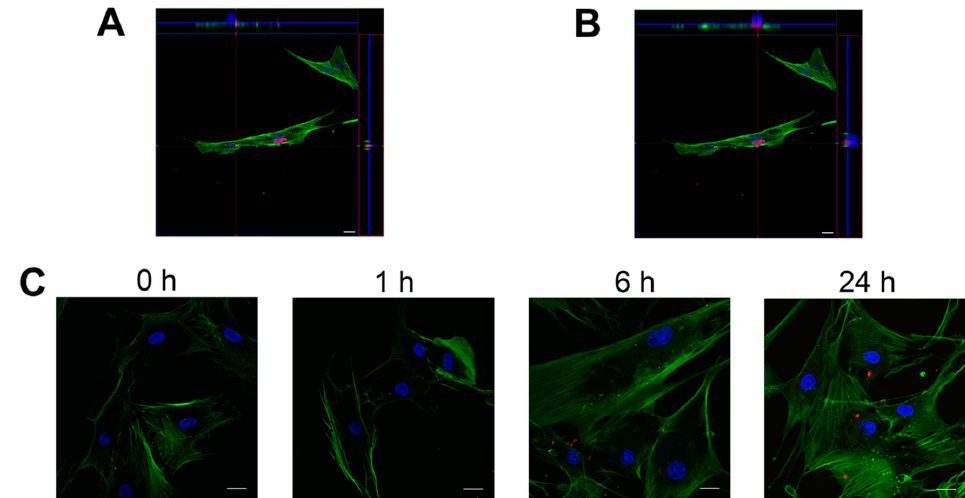
Figure 6. Visualization of NDMVs internalized within FLS by confocal microscopy. NDMVs were incubated with FLS at a ratio of 100. ( A , B ) show representative images of three-dimensional analyses after 24 h of incubation. Nuclei were stained by DAPI (blue) and actin by phalloidin (green), whereas NDMVs were labeled by PKH26 (red). Middle images are optical sections; upper and right panels are vertical cross-sections (red and green lines) of NDMVs from confocal Z-stack series demonstrating single and multiple NDMVs in FLS. ( C ) Representative images at 1 h, 6 h and 24 h. Scale bar: 20 μ m.